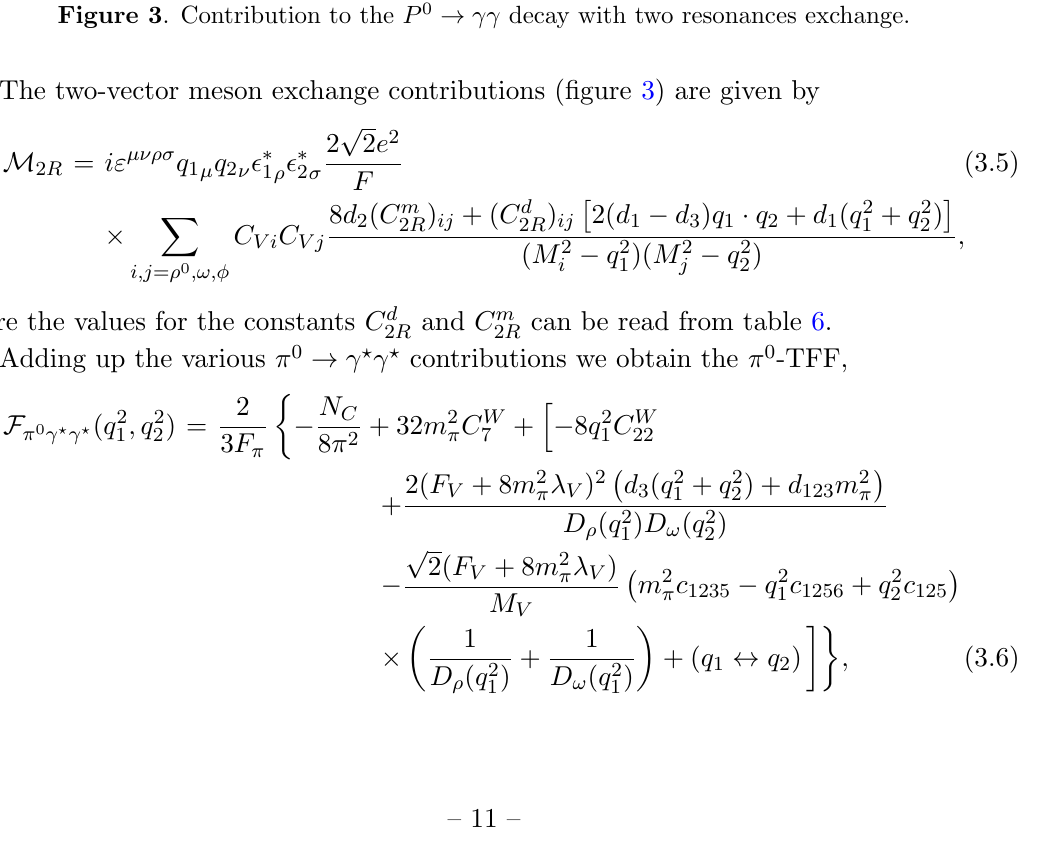
Figure 3 . Contribution to the P 0 ! (cid:13)(cid:13) decay with two resonances